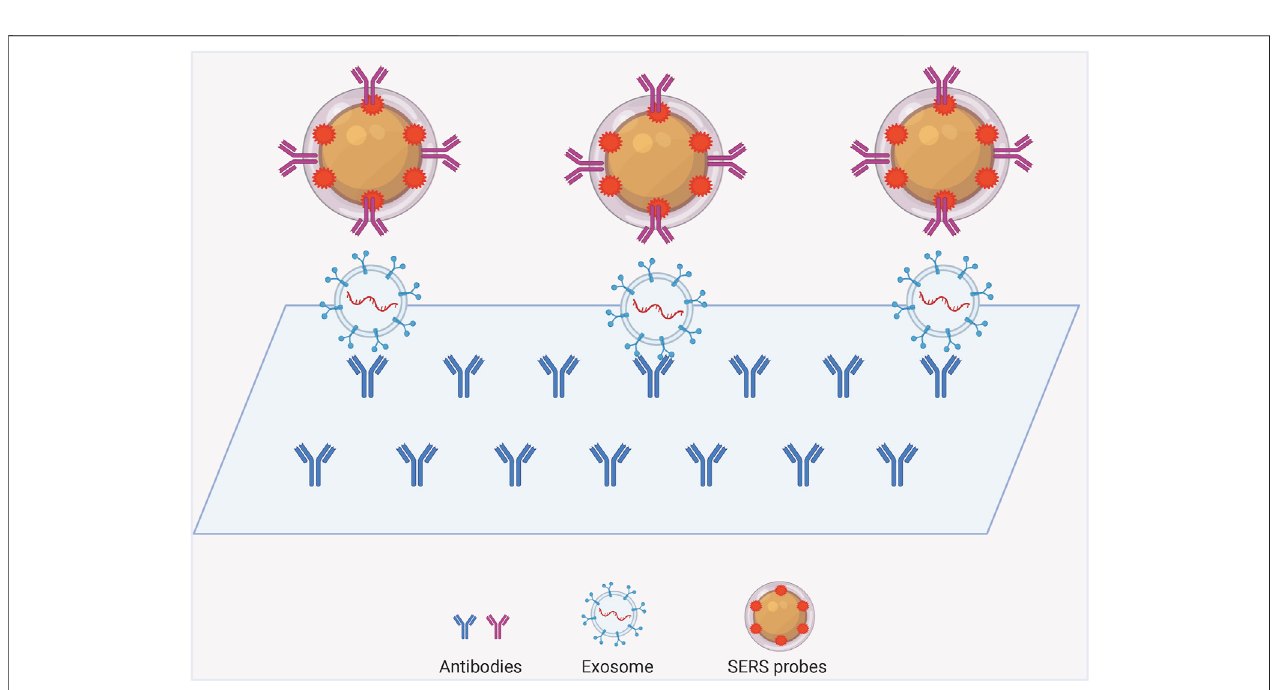
FIGURE 4 | Structural type diagram of exosome-chip-based SERS assay